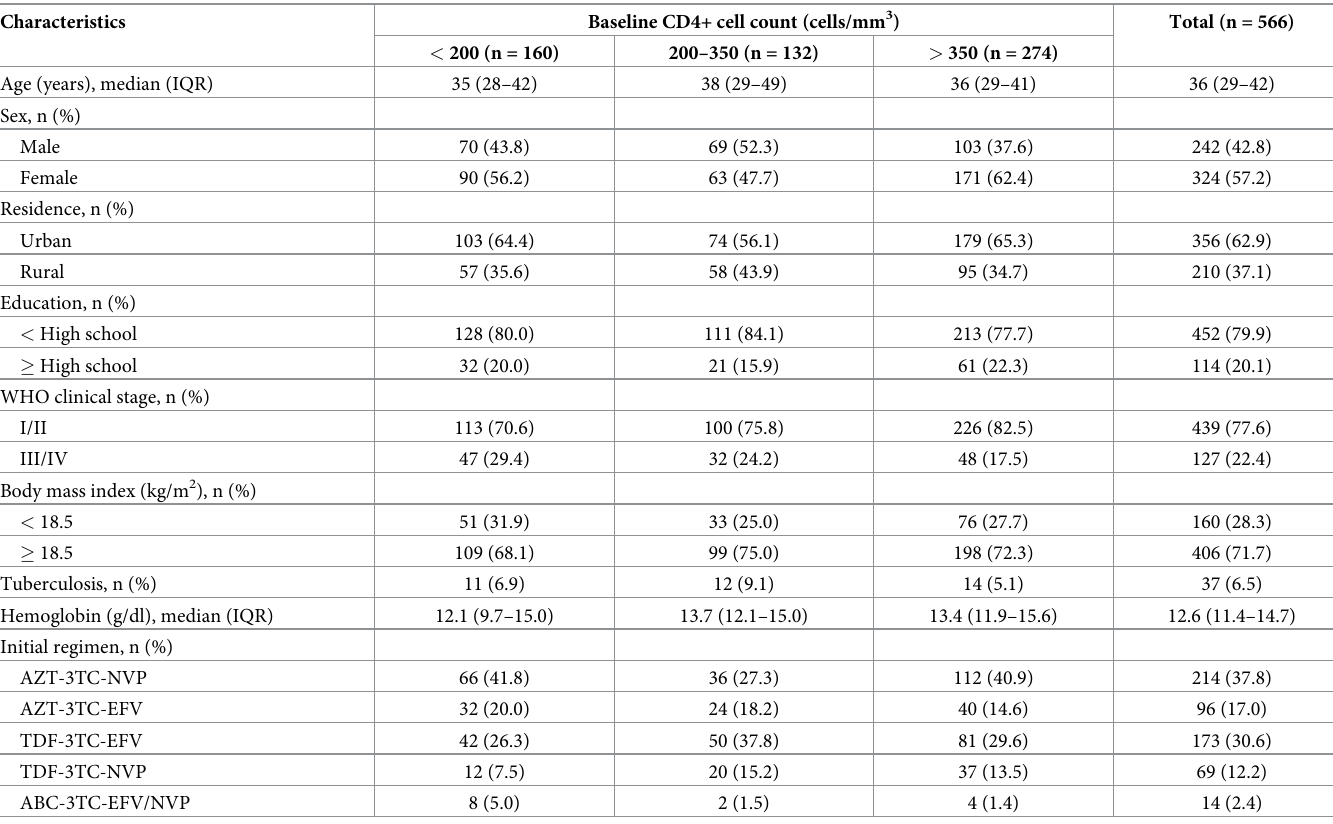
Table 1. Baseline patient characteristics by CD4+ cell count